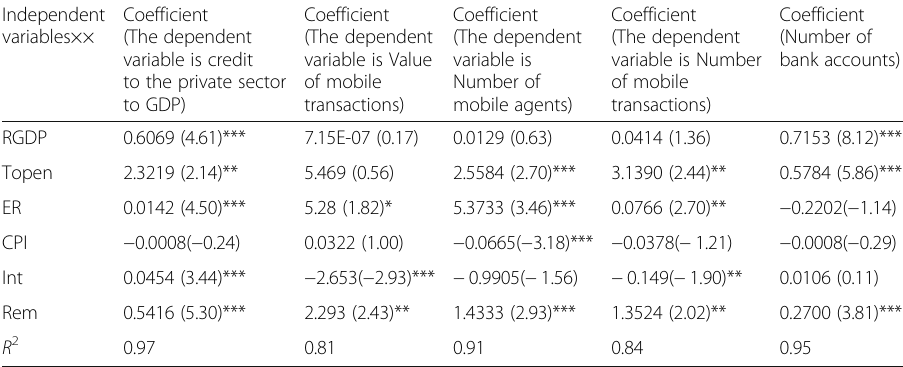
Table 6 Estimated long-run